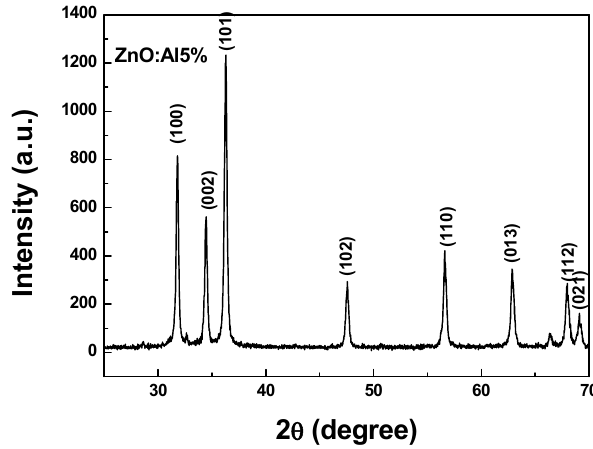
Figure 1. X-ray diffraction spectrum of ZnO: Al5% sample.